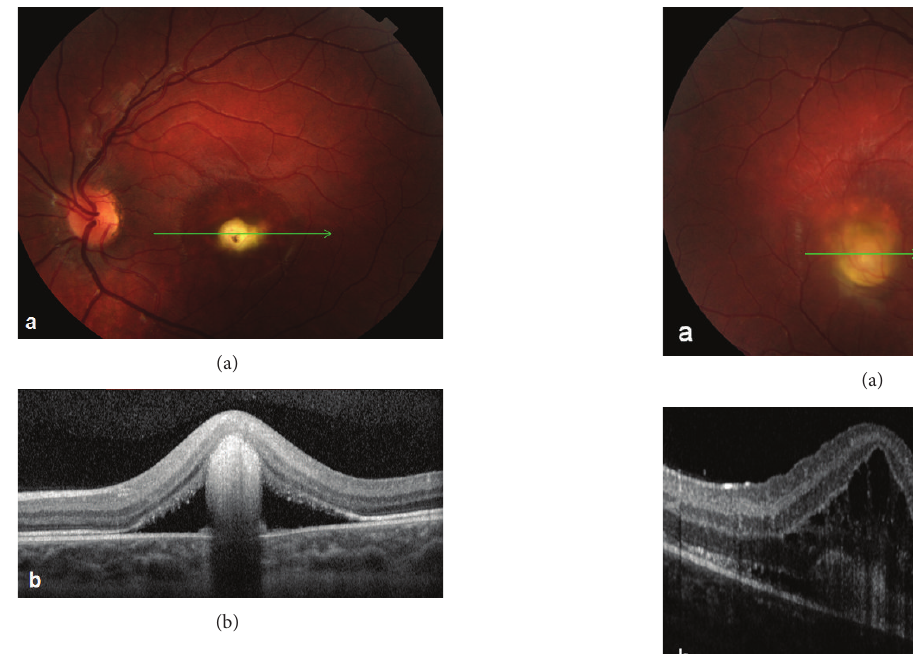
Figure 1: (a) Ophthalmoscopy of the right eye demonstrates round yellow material juxtafoveally, surrounded by subretinal fluid. (b) SD-OCT shows loss of foveal contour, interruption of the external limiting membrane, and the IS/OS junction, with disorganized material in the “vitelliform space” and subretinal fluid.